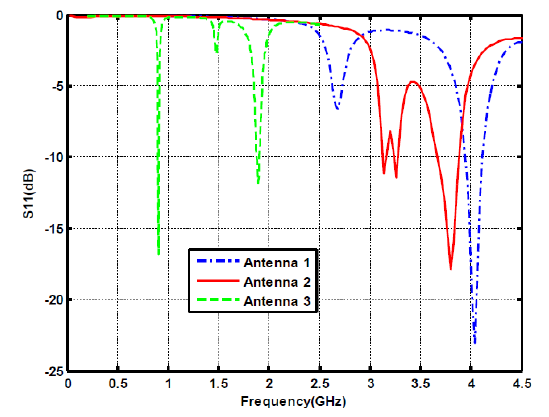
Figure 7: Variation of reflection coeflcient (dB) with frequency on varying height of the substrate( H ).